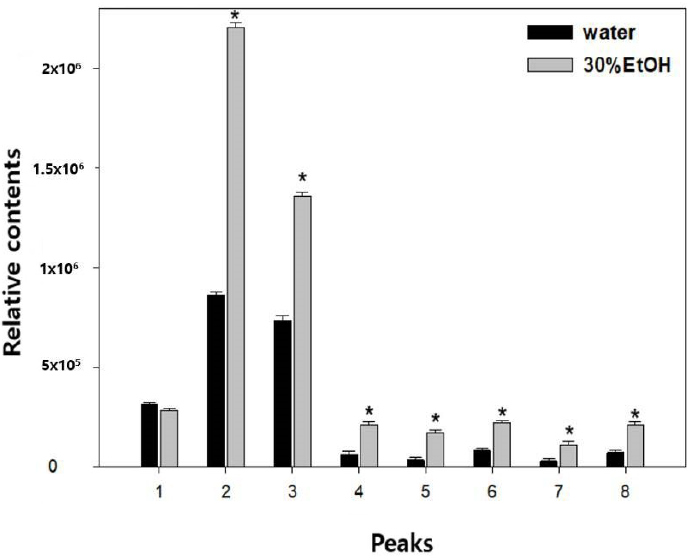
Figure 3. Comparative changes in individual peak marker levels from two extraction solvents. Calculations were based on the area determined from UPLC spectra. Mean ± SD of